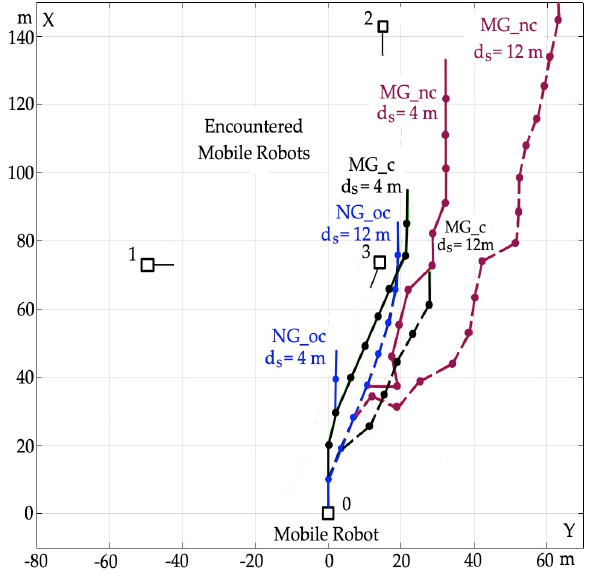
Figure 9. Comparison of safe mobile robot paths when passing K = 3 encountered mobile robots in good weather conditions ( d s = 4 m) and unfavorable weather conditions ( d s = 12 m), determined by the MG_c, MG_nc and NG_oc algorithms.